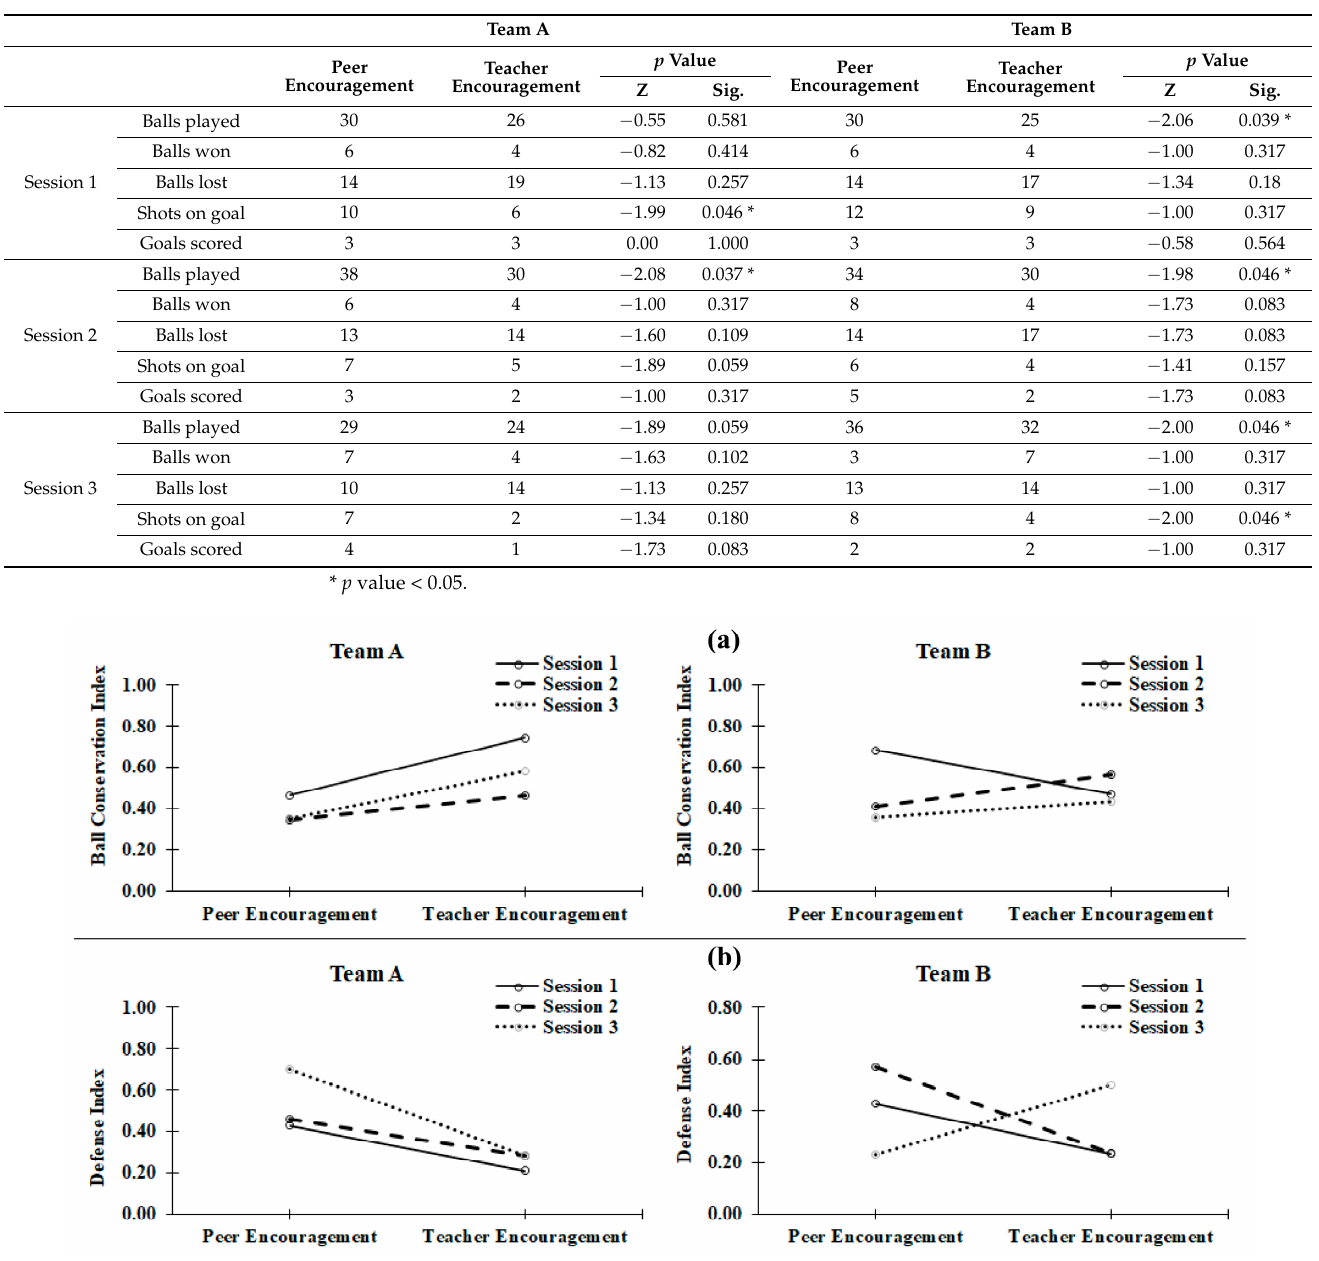
Table 2. The effects of two different modalities of verbal encouragement on technical performance.